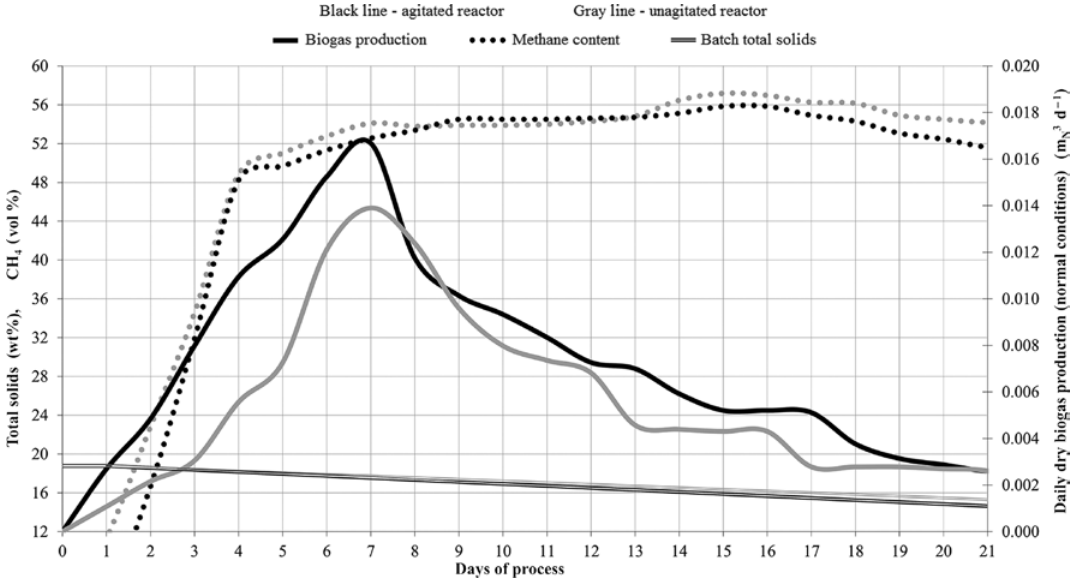
Figure 4: Production and composition of